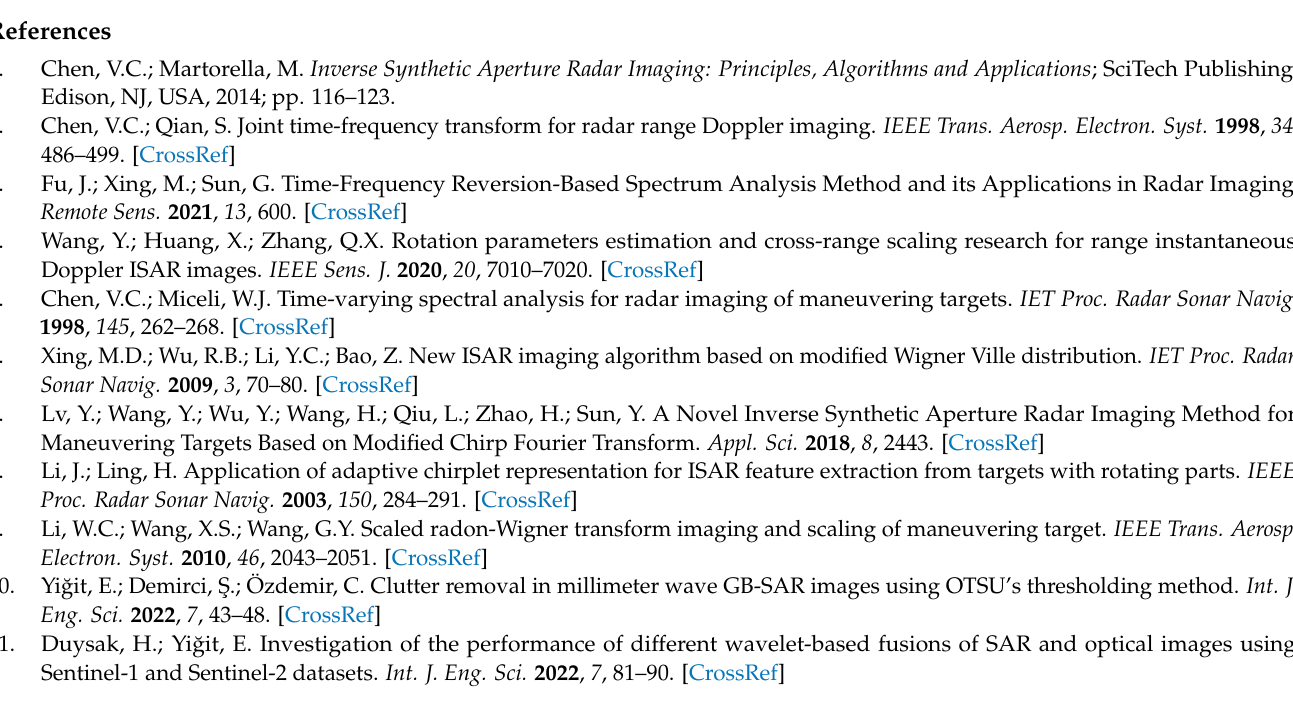
where d i represents the segment spacing after subdivision, rh represents the given roughness and rand represents the random numbers obeying standard normal distribution. 2. Square Step: As shown in Figure A1c,e, the scattering coefficient of the midpoint of each side of the square is calculated